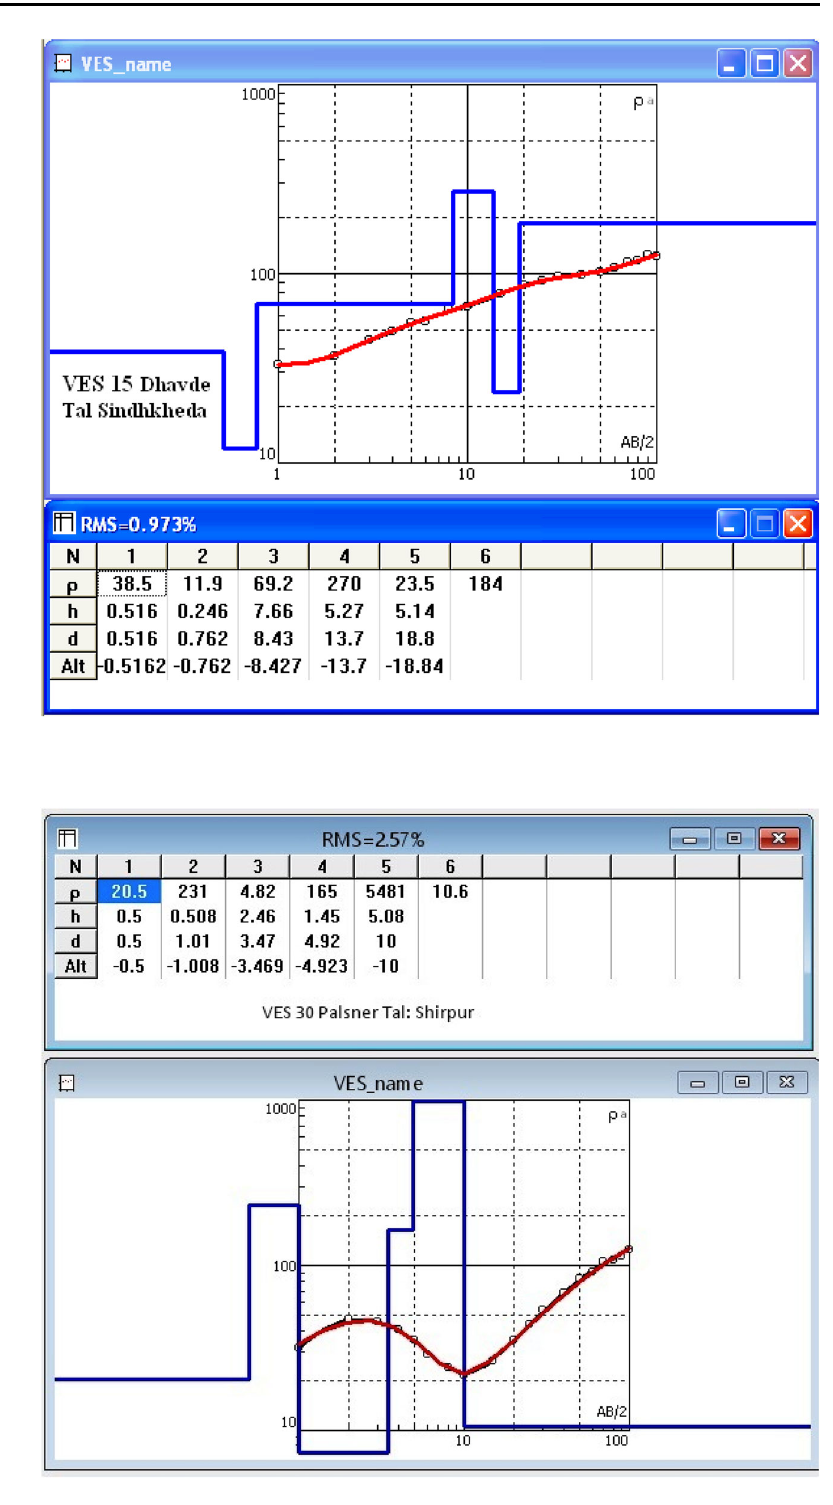
Fig. 9 Representative sounding curves are interpreted as per Orellana and Mooney by